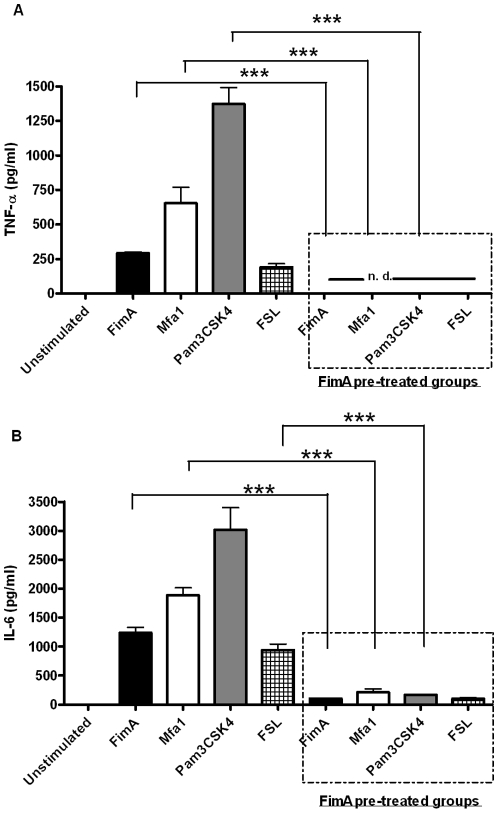
FimA induces TLR2-specific innate tolerance.0.5×106 primary human PBMCs were pre-incubated with rFimA for 24 hrs before stimulation with 1 µg/ml of rFimA, rMfa1 or the TLR2 and -4 specific agonists Pam3CSK4 and E. coli LPS. Responses were compared to cells treated with the same agonists without any pre-incubation. (A) TNF-α; (B) IL-6. n.d.  =  not detected (below assay threshold); ***p<0.001.